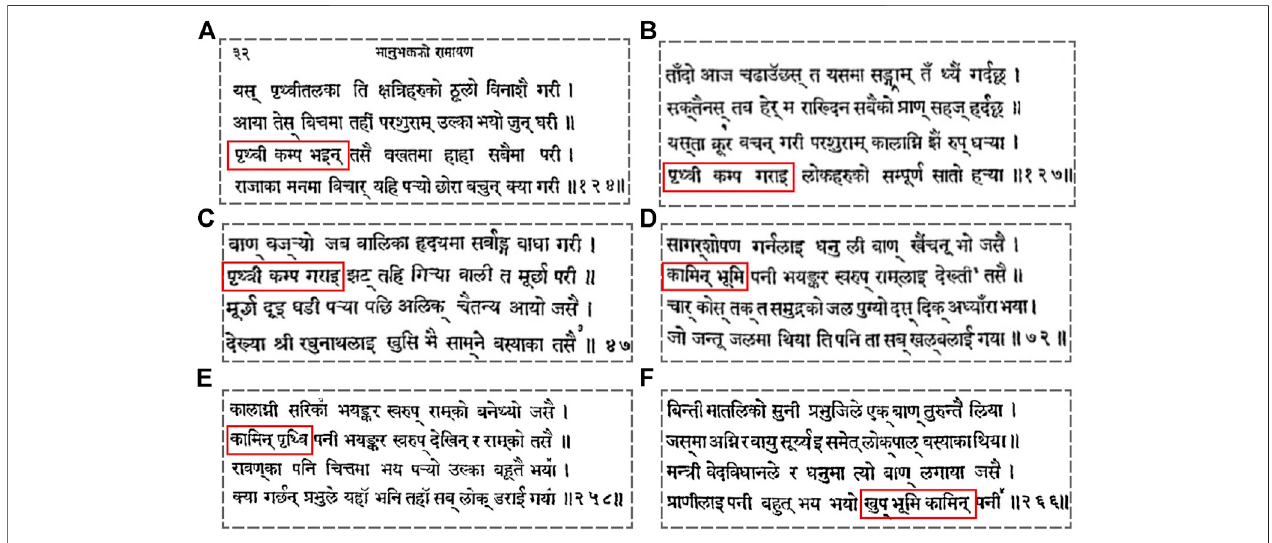
FIGURE 3 | Evidences of earth (Earth) shaking found in Ramayana (Gyawali, 1997). Red rectangles refer to texts where exactly the word “ Earth tremble ” or “ earth shaking ” or “ earthquake ” is written (A – F) . There are a few further evidences of earth shaking which we don ’ t include in this fi gure but which have similar explanation.